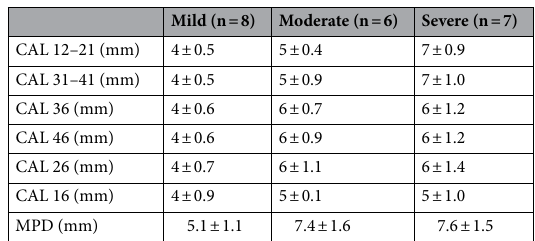
Table 4. Oral clinical parameters of the periodontitis group. Data summarized as mean ± SD. CAL, clinical attachment level; MPD, maximum probing depth.